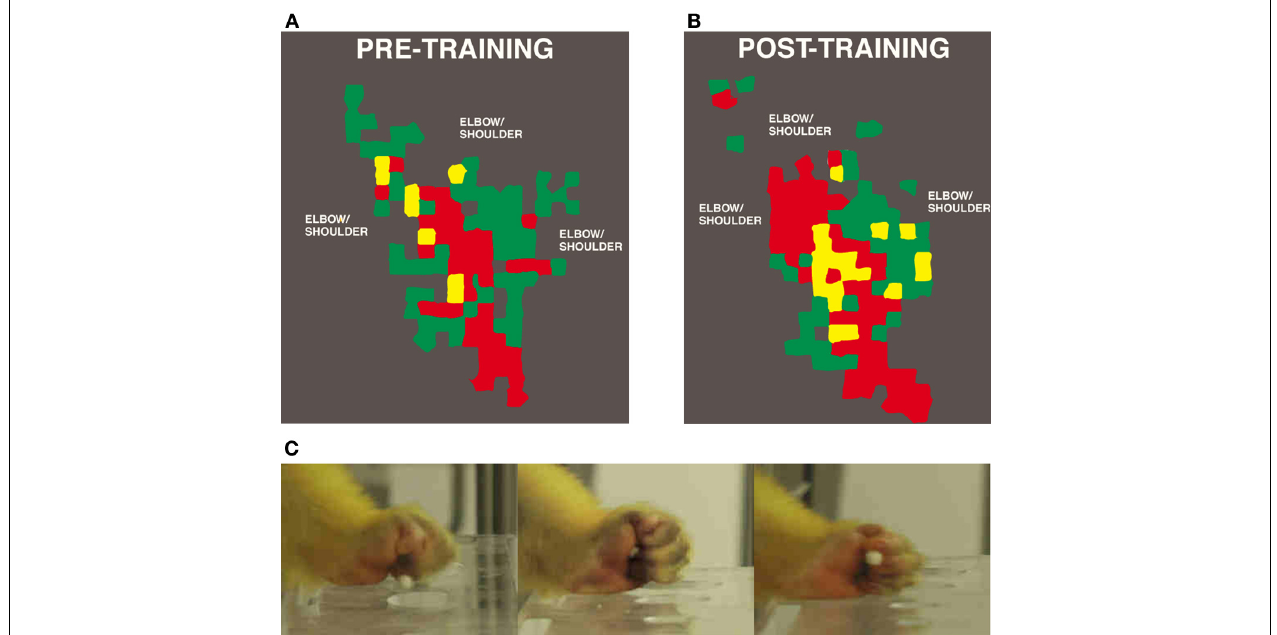
FIGURE 2 | Representation of distal forelimb representations in motor cortexafterdigitskilltrainingasdefinedbyintracorticalmicrostimulation. Digitareas(red) expand after only12 days oftraining. Combination movements